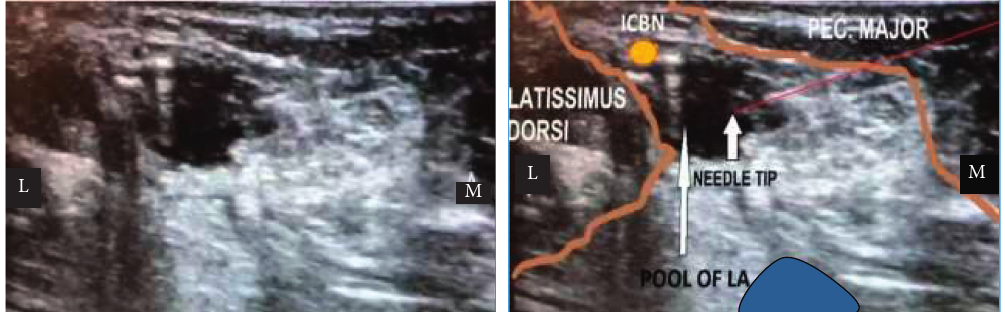
Figure 2: (a) The left panel shows ultrasonic view. (b) The right panel shows ultrasonic view with illustrations. Blue oval indicates the axillary vein. M: medial; L: lateral; ICBN: intercostobrachial nerve.